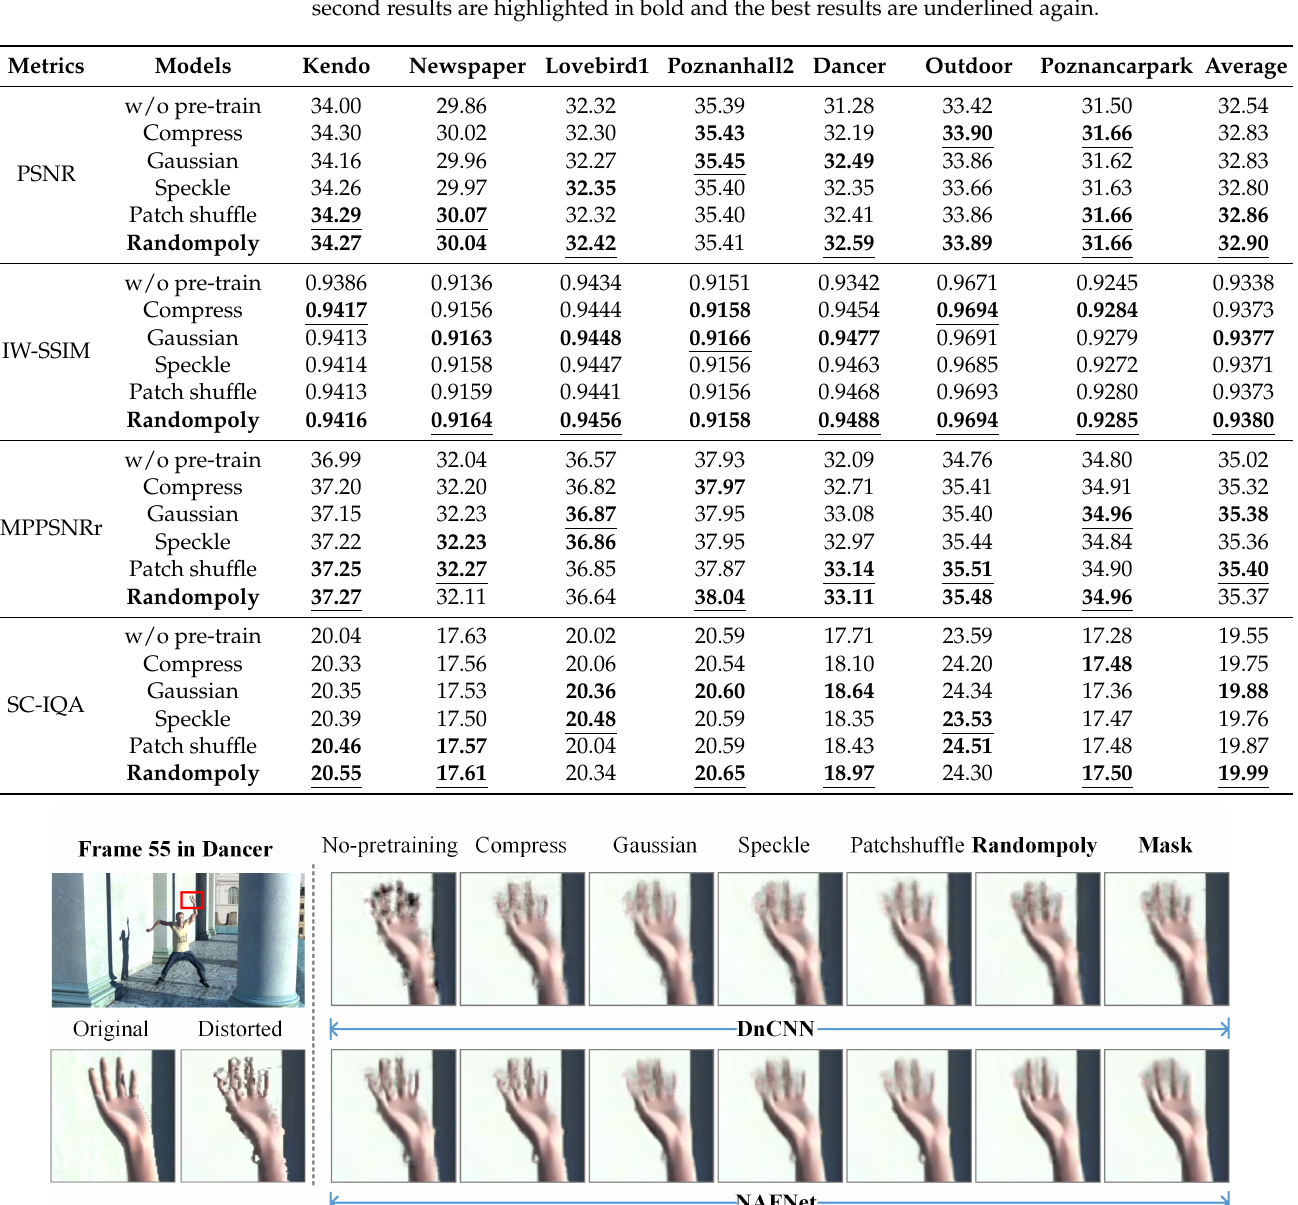
Figure 7. Visual quality comparison of two denoising models, i.e., DnCNN, NAFNet, for SVQE of Dancer with pre-training on synthetic synthesized image database with different random noise types, i.e., compress, Gaussian, speckle, patch shuffle, randompoly (proposed DIBR distortion simulation method), generated from NYU database. ‘Mask’ represents the denoising models that were further integrated with a DIBR distortion mask prediction sub-network using synthetic images generated by ‘randompoly’